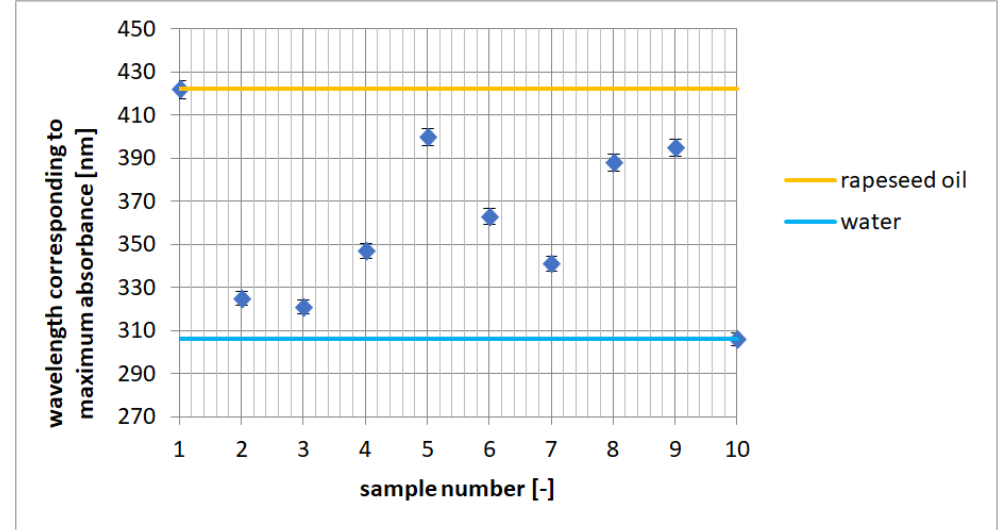
Figure 3. Wavelength corresponding to maximum absorbance for Reichardt’s dye: 1— rapeseed oil, 2 – 9 — DESs, and 10 — water.